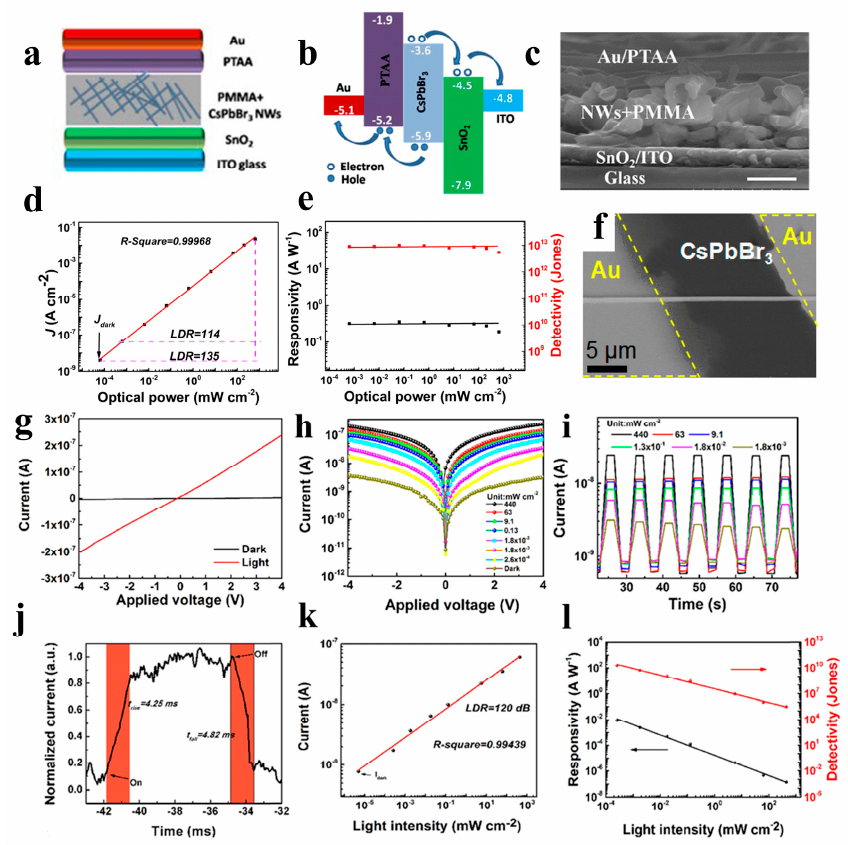
Figure 12. ( a ) Device structure of the perovskite NW PD. ( b ) Relative band ‐ edges of the films in the device. ( c ) Cross ‐ sectional SEM image of the device based on perovskite NW PD (scale bar: 500 nm). ( d ) Linear dynamic range of the PD. ( e ) The responsivity and detectivity of the perovskite PD. Re ‐ produced with permission from reference [105]. Copyright 2018, Elsevier. ( f ) SEM image of the as ‐ fabricated device based on a single CsPbBr 3 NW. Reproduced with permission from reference [108].